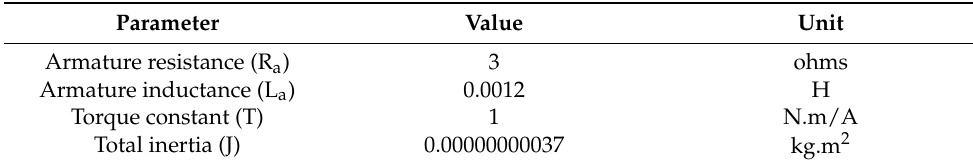
Table 1. Setting up the engine